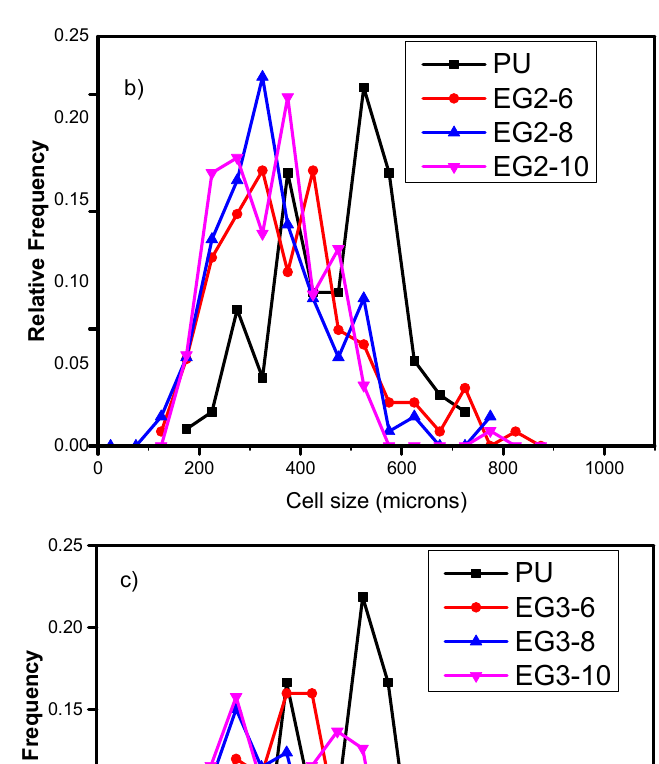
Figure 2. Cell size distribution for ( a ) EG1, ( b ) EG2, and ( c ) EG3 RPUF samples.